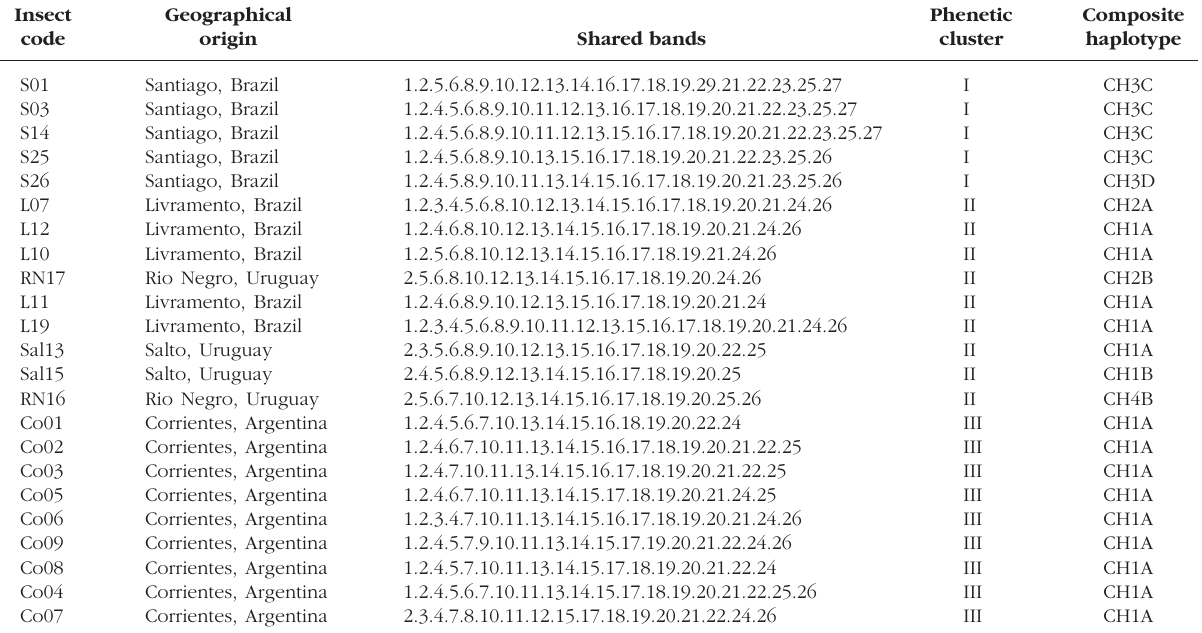
Table I. – Electromorphs (shared bands) observed after amplification with the three RAPD primers, the phenetic clusters and respective haplotypes obtained among the Triatoma rubrovaria populations analysed.